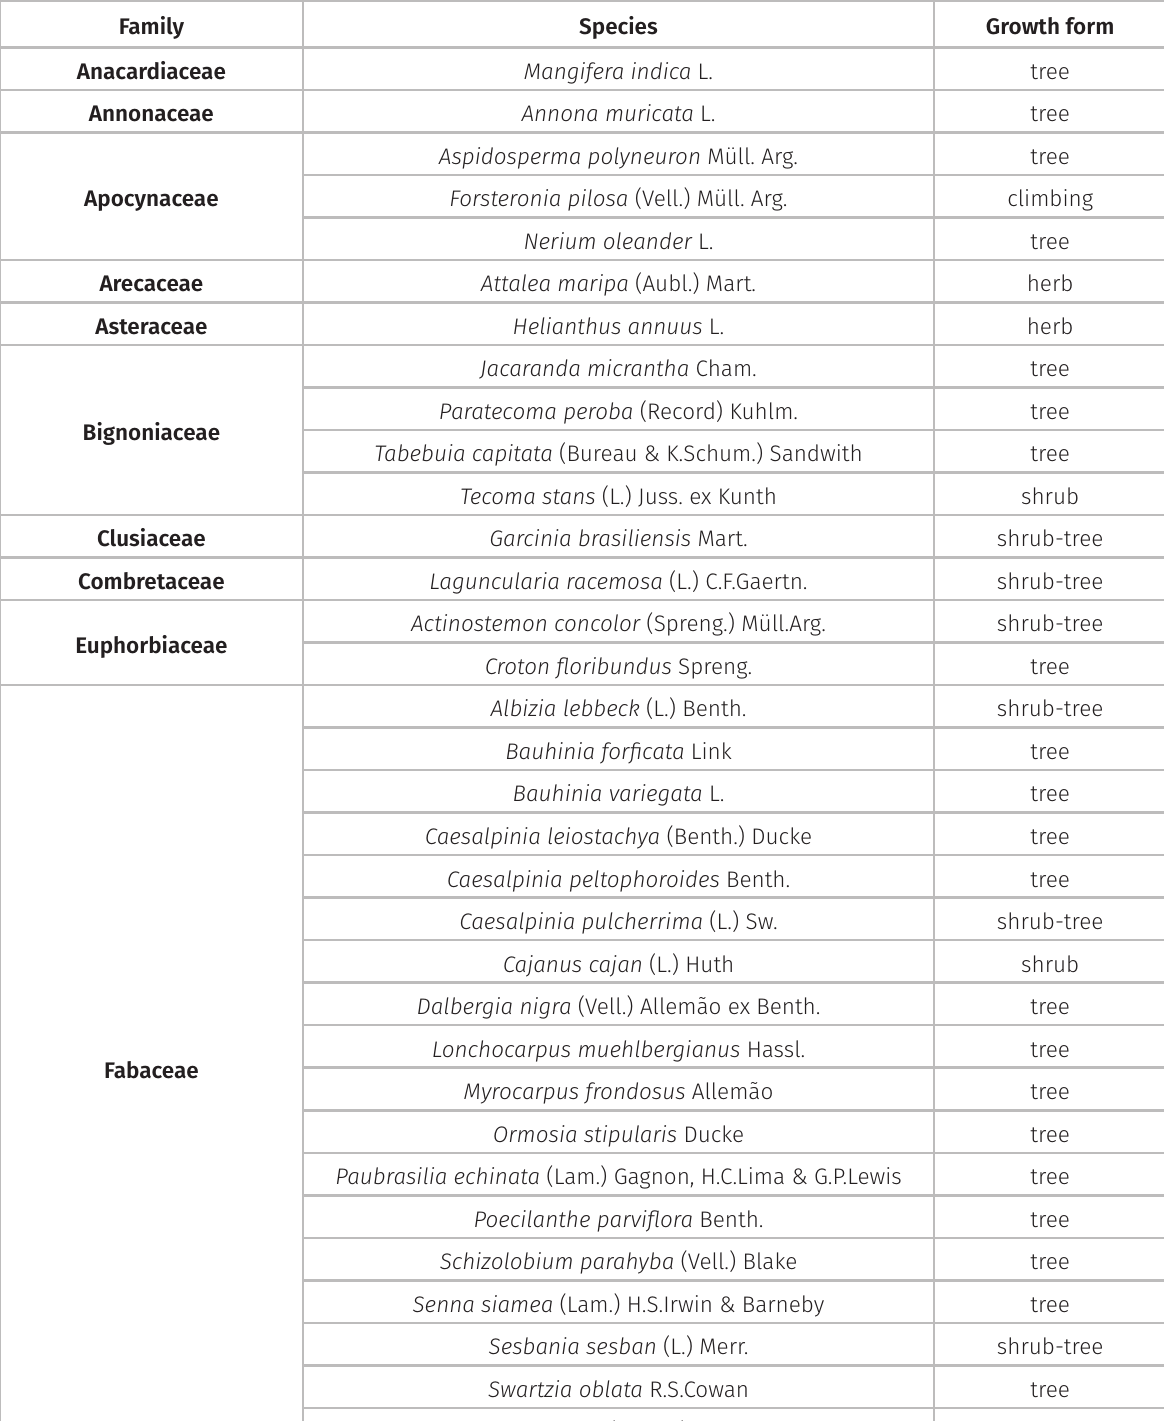
Table VIII. Plant species used in assisted regeneration of the Cerrado and exotic to the